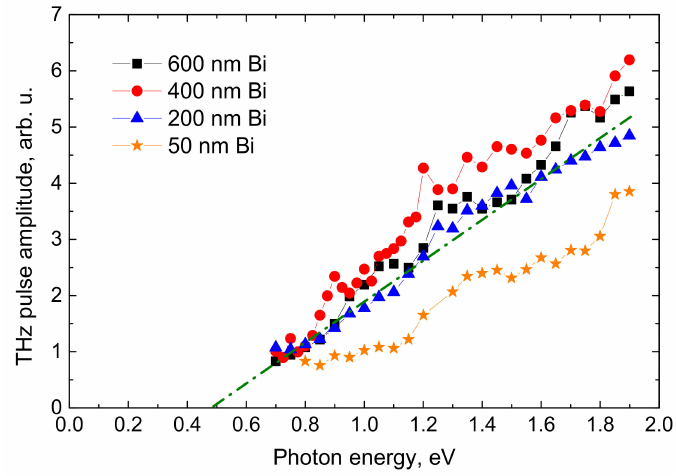
Figure 6. THz pulse amplitudes normalized to the number of photons in femtosecond optical pulses as a function of the photon energy. The experiment was performed on the four different thickness Bi layers grown on gold